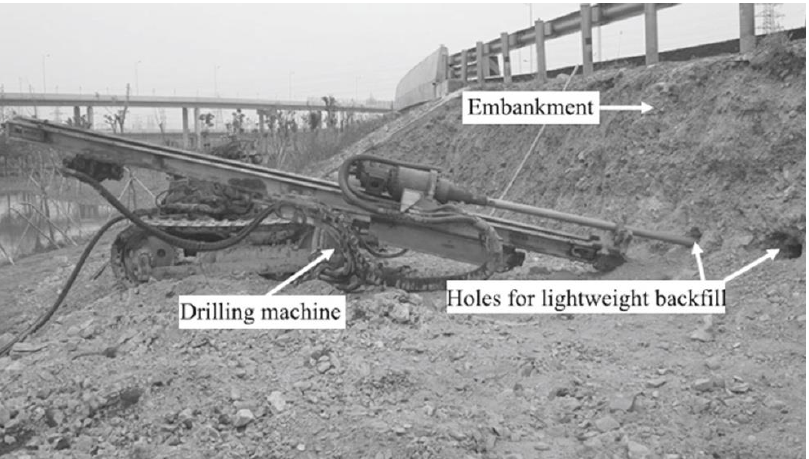
Figure 3. Drilling holes on north sides of the embankment. Reprinted with permission from Ref. [18]. Copyright 2021 IEEE Proceedings.